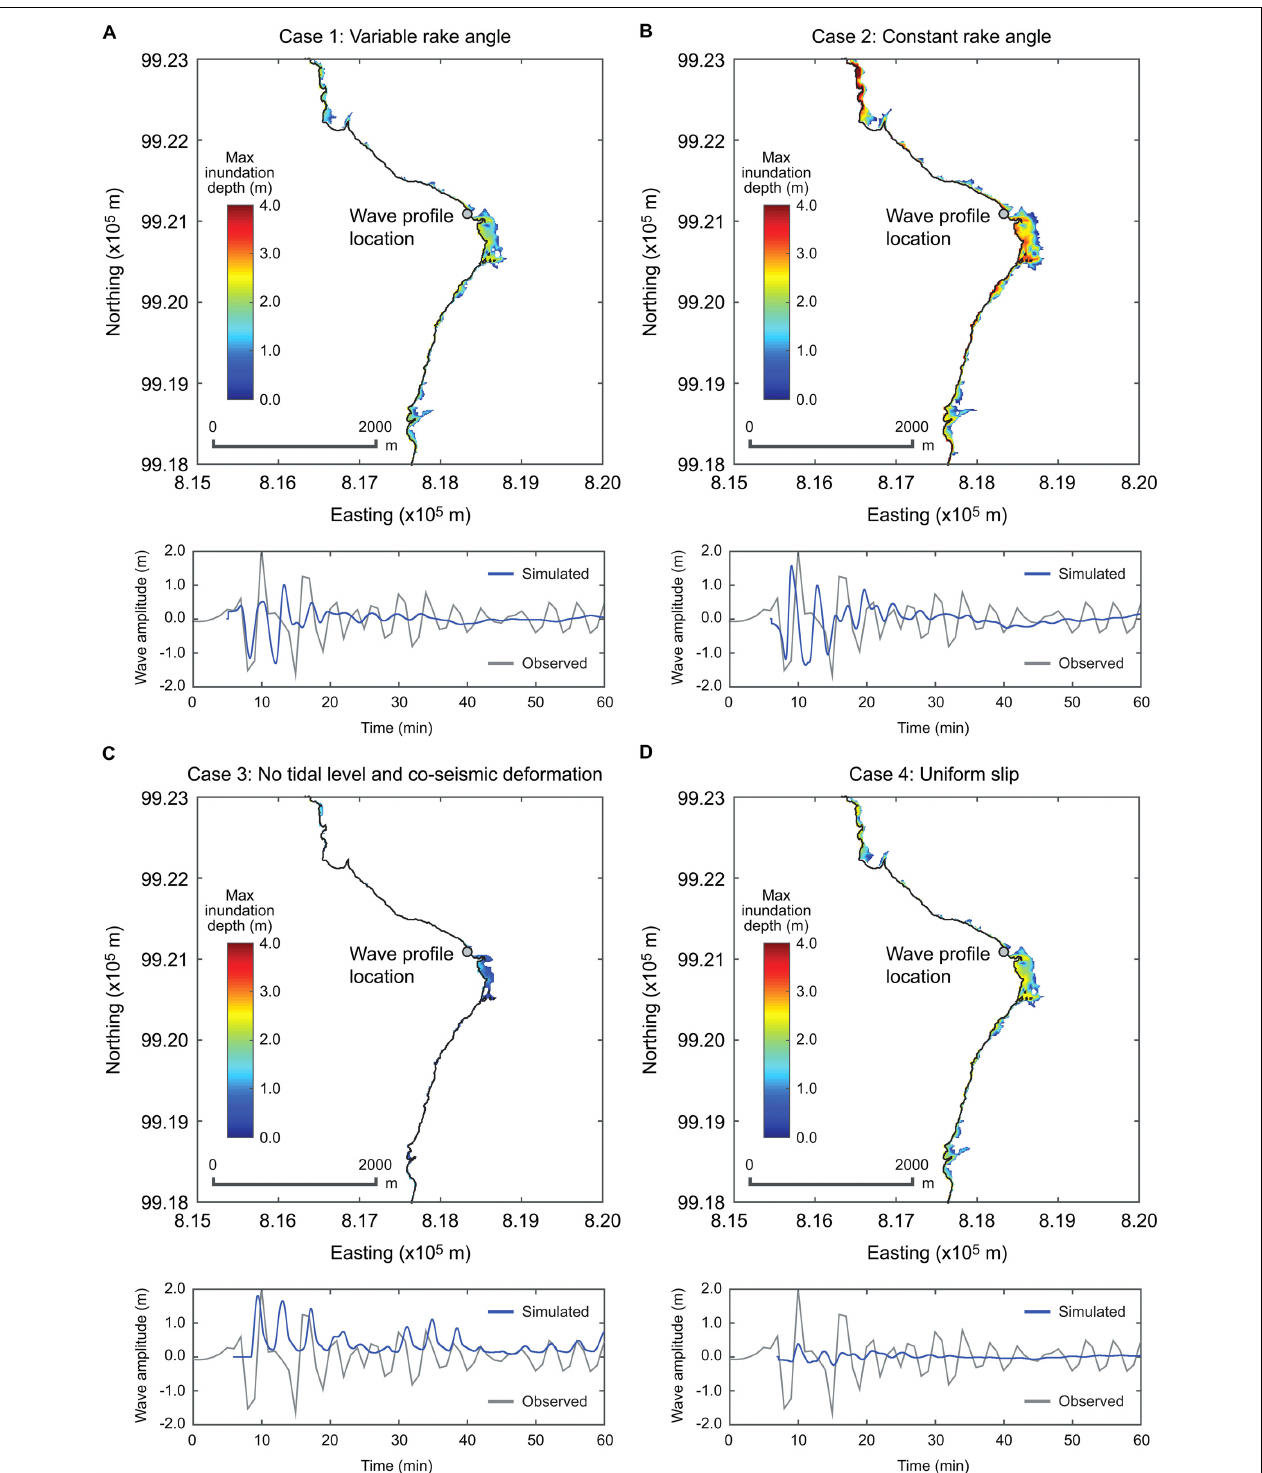
FIGURE 12 | Tsunami inundation simulation results in the Pantoloan area (see Figure 10C ): (A) the USGS model with the variable rake angle (Case 1), (B) the USGS model with the constant rake angle (Case 2), (C) the USGS model with the uniform slip distribution with the constant rake angle (Case 3), and (D) the USGS model with the variable rake angle without considering the effects of tidal level and co-seismic ground deformation (Case 4). For Cases (A–C) , the maximum inundation depth is computed by taking into account co-seismic ground deformation and tidal level, while the wave profile at the near-shore location (indicated by a gray circle on a map) is with respect to the reference level of the tsunami simulation. The simulated wave profiles are shifted in time to match the initial phases of the waves.